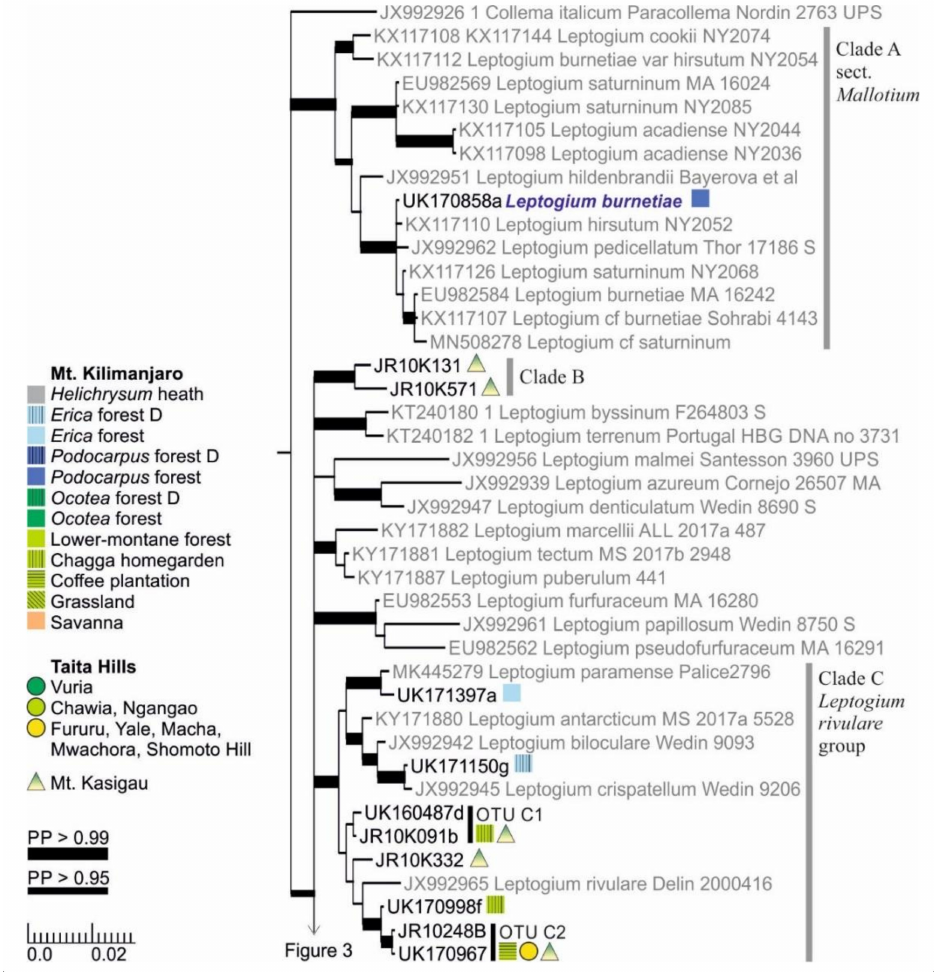
Figure 2. Clades A–C of the Bayesian tree of the genus Leptogium based on the mtSSU and 5.8S marker regions (Figure S2). Newly obtained sequences are in black, including one specimen representing each mtSSU variant; all specimens belonging to each clade are listed in Table S1. Established species are in blue. The colored shapes (rectangle, circle, triangle) show the distribution and abundance of the taxa in the studied regions and ecosystem types: On Mt. Kilimanjaro, each vegetation zone is indicated by color while the disturbed ecosystem types are further separated with grid; the widths of the rectangles indicate the number of sample plots in which the taxon was present in each ecosystem type (square = 1). In Taita Hills, each circle indicates presence in one forest fragment. On Mt. Kasigau, each triangle refers to presence on one collection transect, corresponding to the northern, eastern, southern, and western slopes of the mountain. Strong support (>0.95) for a clade (posterior probability, PP) is indicated with a thicker branch while the precise values are shown in Figure S2. The scale refers to nucleotide substitutions per site. D =